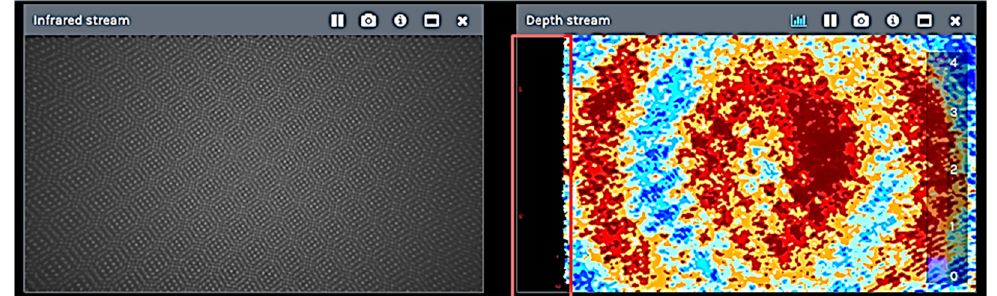
Figure 2. The static infrared dot pattern projected on a wall ( left ); highlighted in red is the non-overlapping region on the field of view of the left and right image ( right ).